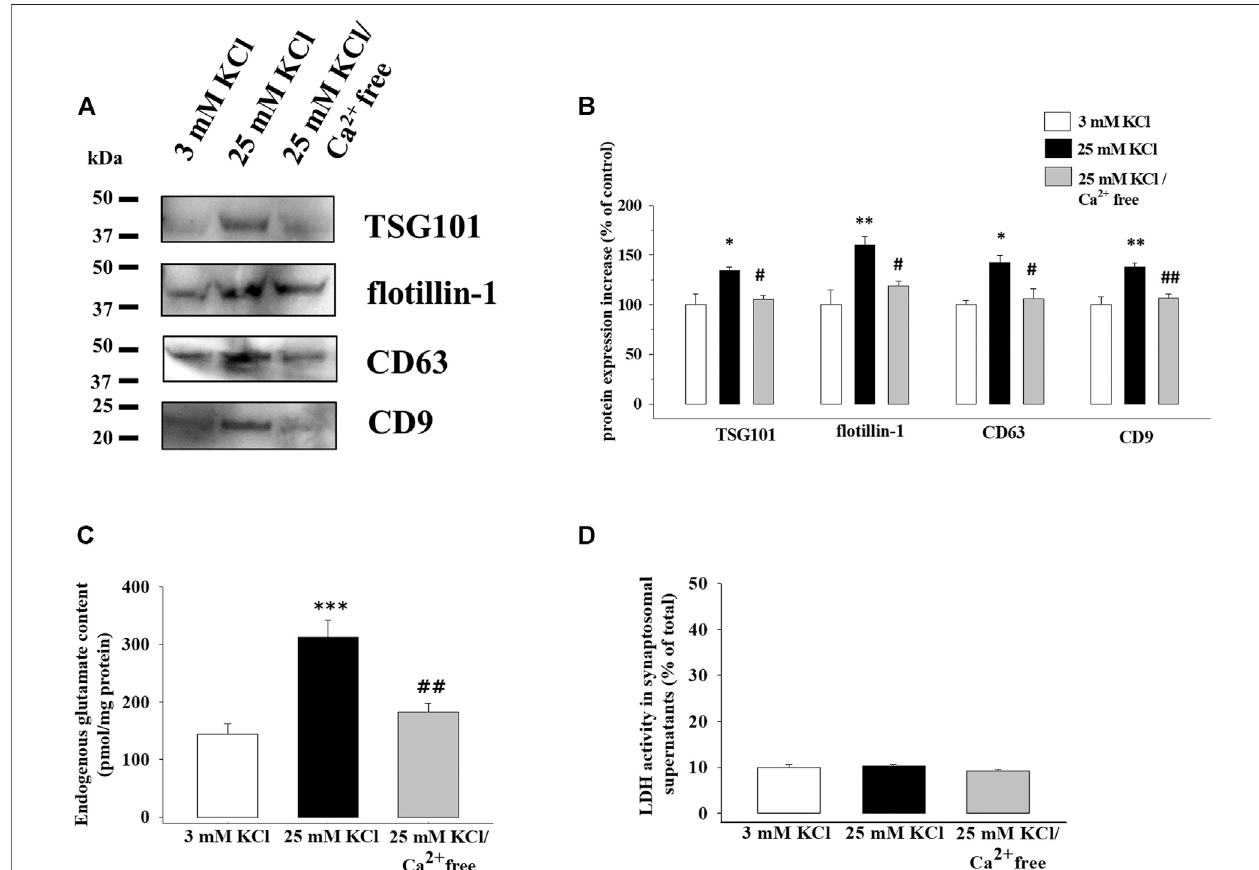
FIGURE5 | ReleaseofexosomesfromcorticalsynaptosomesisaCa 2+ -dependentevent.Synaptosomeswereincubatedfor2mininbasalcondition,ina25mMKCl mediumcontaining1.2mMCa 2+ ionsorlackingCa 2+ ions(Ca 2+ freemedium). (A) WesternblotexperimentswerecarriedouttoanalyzeTSG101, fl otillin-1,CD63,andCD9 protein content in the exosomal fractions isolated from the supernatants of the synaptosomes under the three experimental conditions (respectively, lane 3 mM KCl, lane 25 mM KCl,and lane 25 mM KCl/Ca 2+ free).The image isrepresentative ofthe results of n (cid:1) 4 (TSG101), n (cid:1) 5 (CD63), n (cid:1) 6 (CD9),and n (cid:1) 8 ( fl otillin-1)Western blot analyses. (B) Quanti fi cation of the change in TSG101, fl otillin-1, CD63, and CD9 proteins in the exosomal fraction from the supernatants of the synaptosomes exposed to 25 mMKCl/Ca 2+ -freemedium(graybars)whencomparedto25 mMKCl/1.2 mMCa 2+ medium(25 mMKCl,blackbars).Resultsareexpressedaspercentofcontrol(3mM KCl,emptybars).Datarepresentthemean ± SEM.* p < 0.05vs.respectivecontrol;** p < 0.01vs.respectivecontrol; # p < 0.05vs.25 mMKCl; ## p < 0.01vs.25 mMKCl. (C) Endogenousglutamatecontentinthesupernatantsofthesynaptosomesincubatedin3 mMKClmedium(emptybar),25 mMKCl/1.2 mMCa 2+ -containingmedium(25 mM KCl, black bar), and 25 mM KCl/Ca 2+ -free medium (gray bar). The endogenous glutamate content is expressed as pmol/mg synaptosomal proteins. Data represent the mean ± SEM of the analysis of n (cid:1) 11 samples. *** p < 0.001 vs. 3 mM KCl; ## p < 0.01 vs. 25 mM KCl. (D) Lactate dehydrogenase (LDH) activity in the supernatants of the synaptosomesincubatedin3 mMKClmedium(emptybar),25 mMKCl/1.2 mMCa 2+ -containingmedium(25 mMKCl,blackbar),and25 mMKCl/Ca 2+